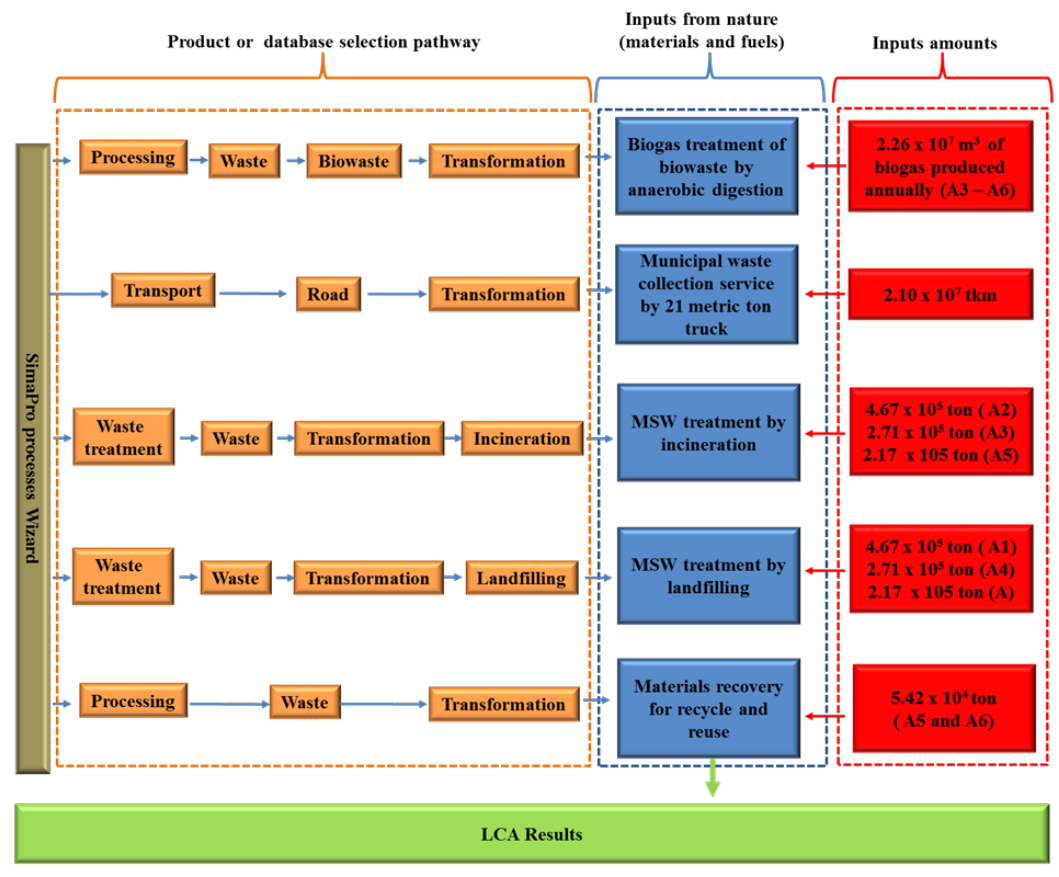
Figure 3. LCA methodological framework.